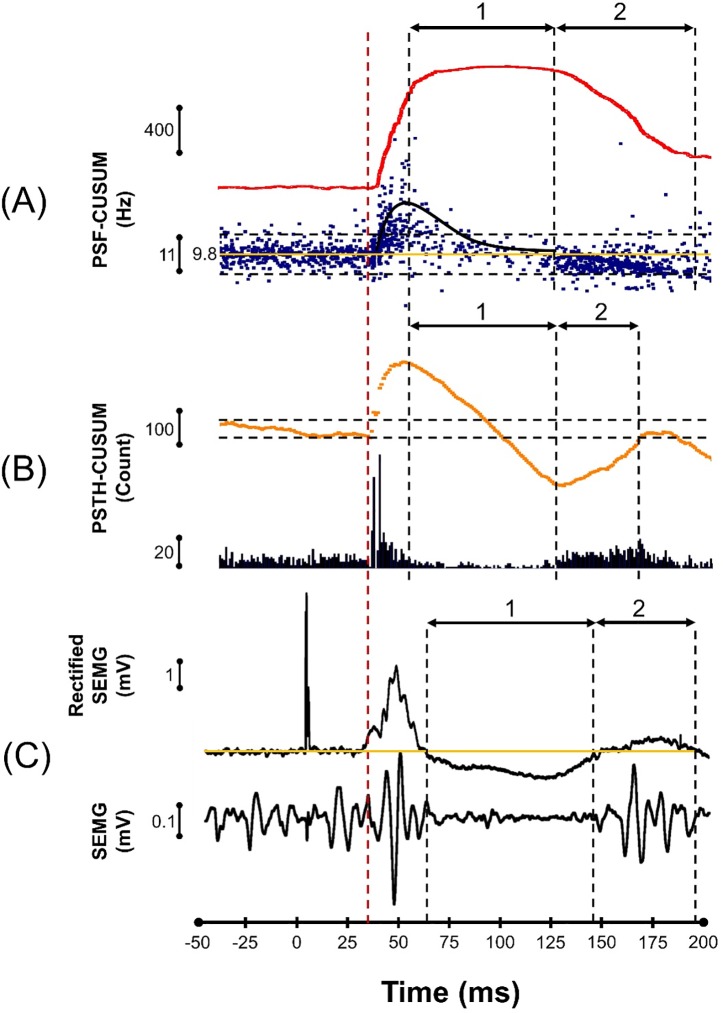
Representation of MEP and early (1: CSP) and late (2: Rebound activity period) post-MEP events with a stimulus intensity that generated 30-motor unit occurrences at the MEP period per 100 stimuli in TA. Black vertical dashed lines indicate the post-MEP event onsets and endpoints while red dashed line indicates MEP latency. Black horizontal arrows present CSP (1) and Rebound activity period (2). Early post-MEP period is the classical CSP and the late period is the classical ‘Rebound Activity’ that terminates the CSP. (A) PSF illustrates the frequency pattern of the unit together with its CUSUM (top trace). Horizontal dashed lines indicate 2 x SD according to the pre-stimulus firing rates and yellow line is average background discharge rate which was 9.8 Hz. (B) PSTH represents the firing probability of the unit, represented with its CUSUM (orange trace above). Dashed lines in CUSUM indicate the error box limits (see Methods). (C) Averaged-rectified SEMG-CUSUM response shows the MEP latency and reduced activity (black trace above).